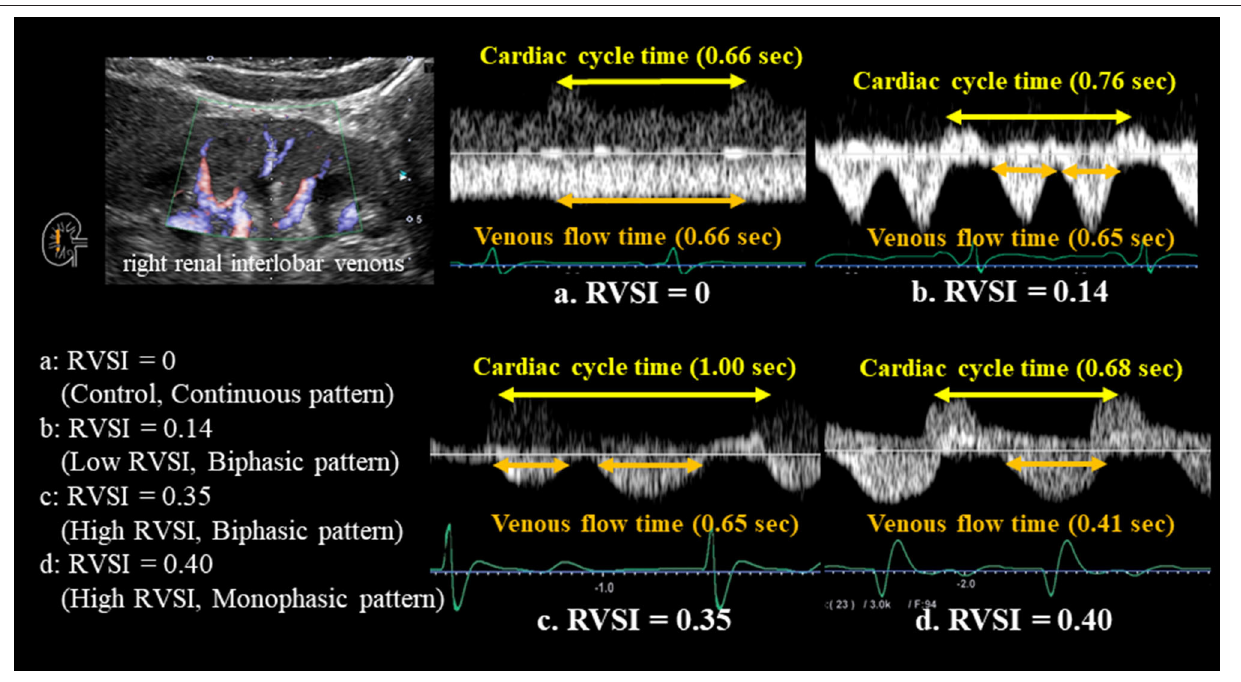
FIGURE 1 | All renal Doppler ultrasonography studies were performed in the right kidney. Color Doppler images were used to record pulsed Doppler waveforms of the interlobar arteries and veins simultaneously. The upward Doppler signal indicated the intrarenal arterial flow, and the downward Doppler signal indicated the venous flow. We measured venous flow time and calculated RVSI as follows: (cardiac cycle time-venous flow time)/cardiac cycle time. RVSI of 0 was defined as the control. RVSI above 0 were divided based on the median value of RVSI (0.21): the low RVSI (0 < RVSI ≤ 0.21) and the high RVSI (RVSI > 0.21). RVSI increased with increasing severity of renal congestion. This figure shows representative IRVF patterns with RVSI in a patient with HF. IRVF patterns were broadly categorized into continuous (RVSI = 0, non-congestive) and discontinuous (RVSI > 0, nadir velocity = 0) flow patterns. We further classified the discontinuous IRVF patterns into